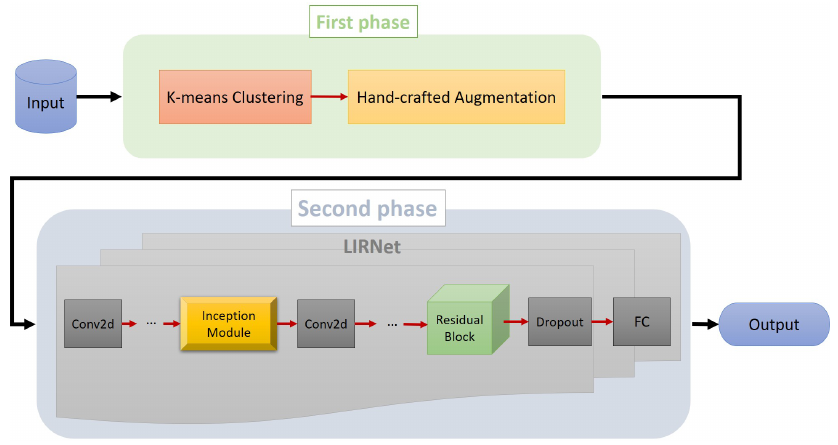
Figure 1. The proposed